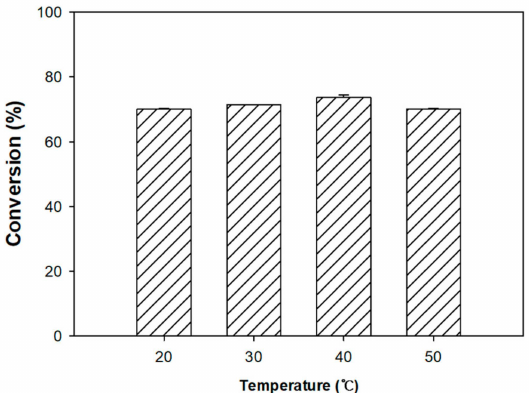
Figure 5. E ff ect of reaction temperature on the Novozym 435-catalyzed synthesis of phenethyl formate. The conversion yield (%) was calculated by GC